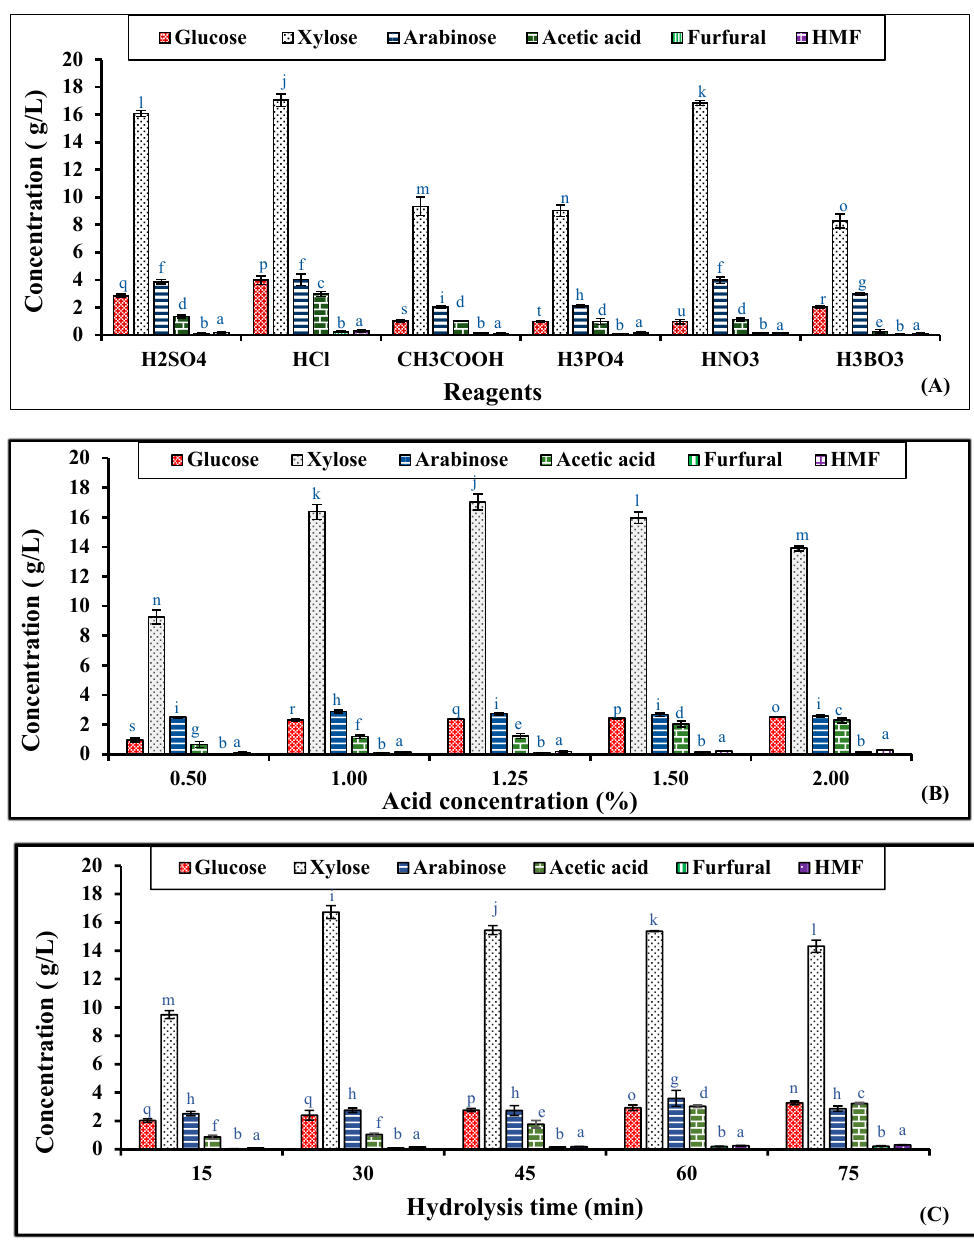
Figure 1. Optimization of RS hydrolysis by varying different ( A ) reagents, ( B ) sulfuric acid concen- trations (0.5 to 2.0%), and ( C ) residence times of rice straw hydrolysis by 1.25% sulfuric acid (15 to 75 min). Significant differences were calculated by two-way ANOVA using Bonferroni post-tests and are indicated by small letters. At different hydrolysis conditions, the bars with different lower- case letters represent significant differences. Bars with the same letters are not significantly different, according to p < 0.0001.